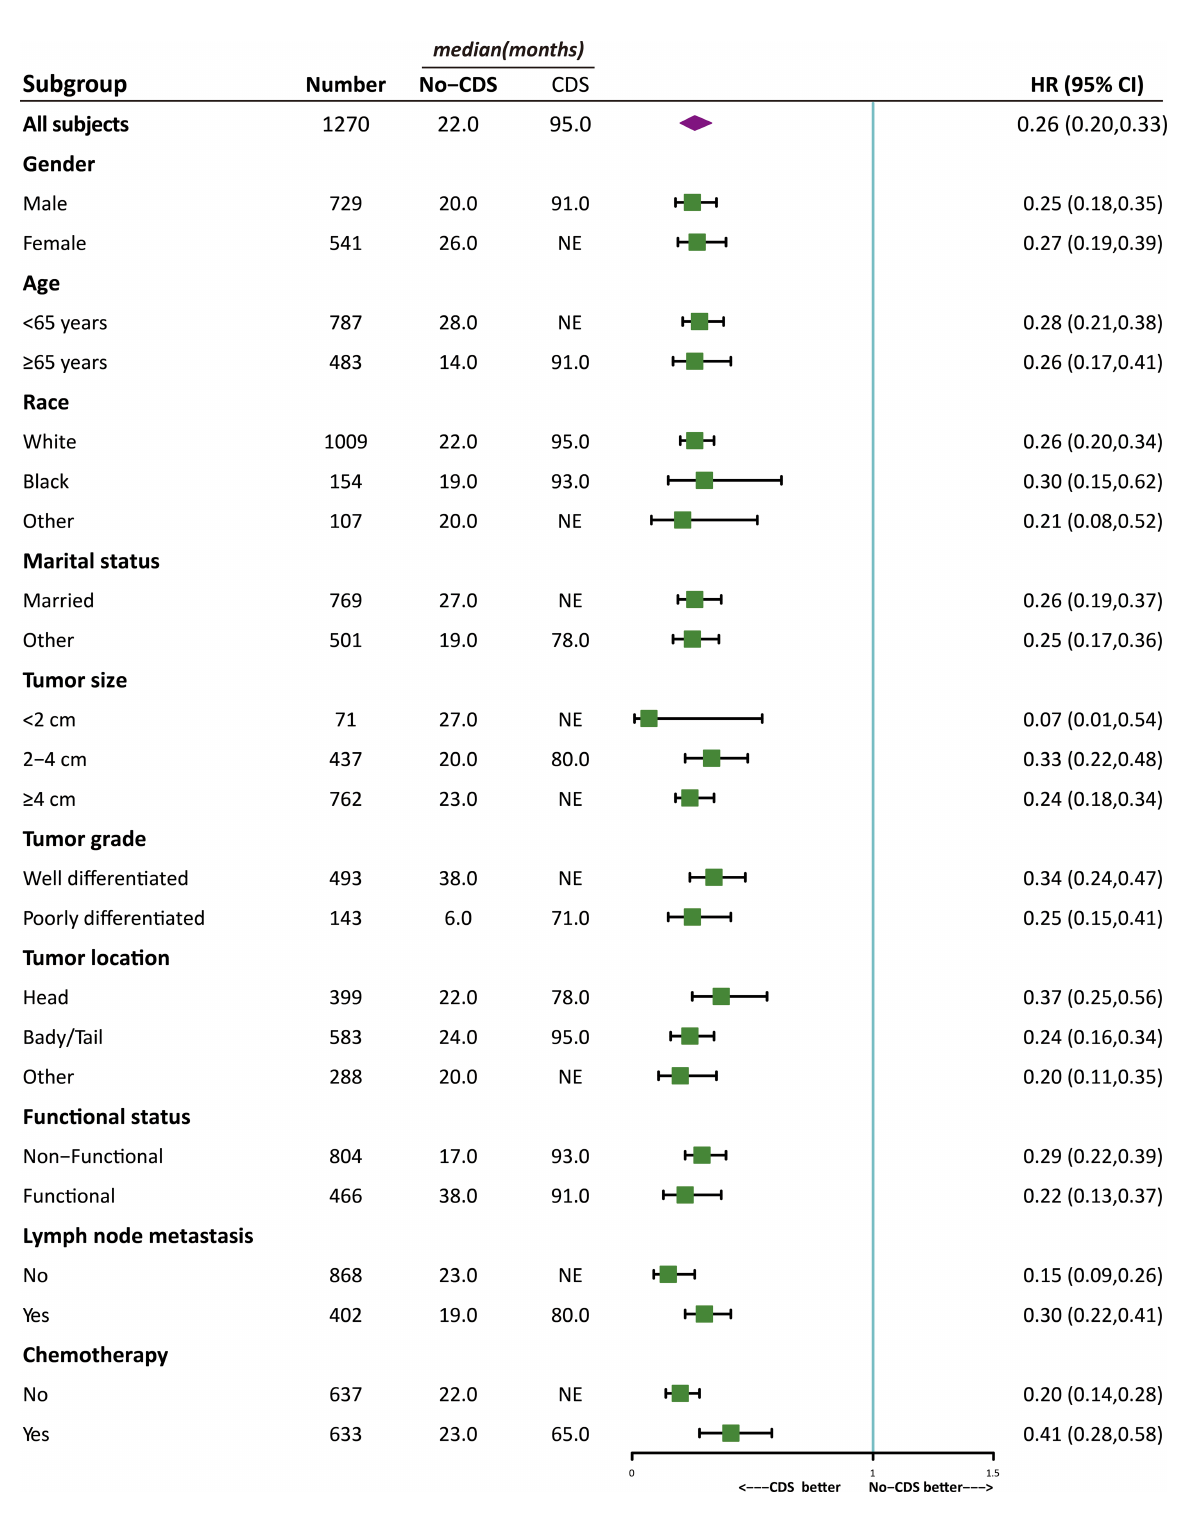
FIGURE 3 | Effect of CDS on OS in all prespeci fi ed